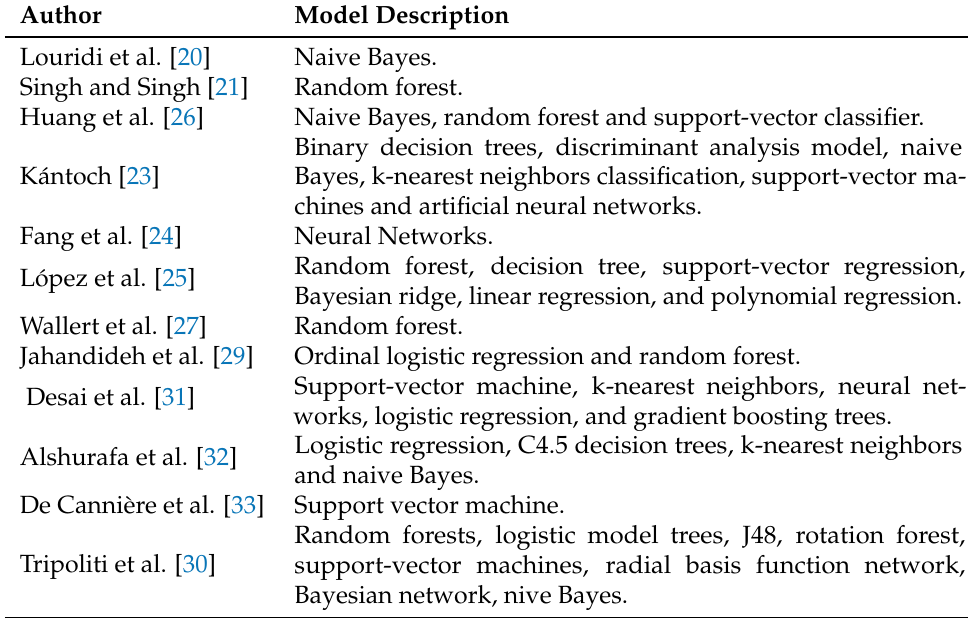
Table 1. Summary of some of the state-of-the-art models used in AI support for cardiovascular